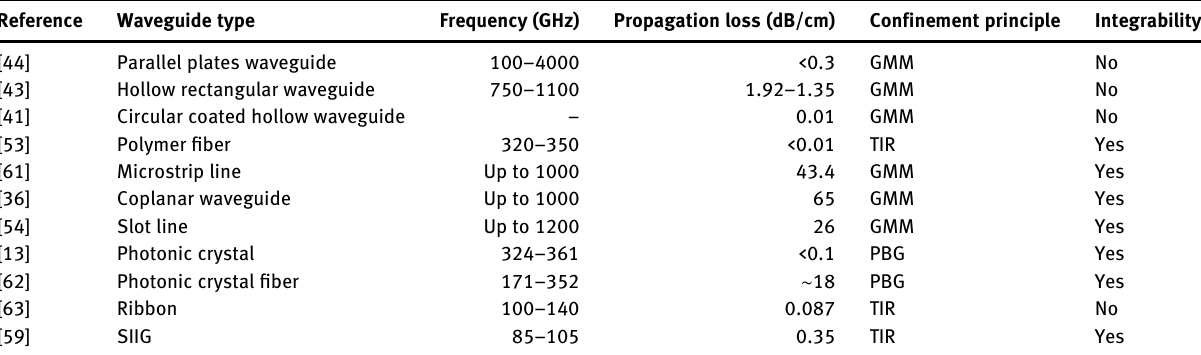
Table  : Performances of various THz waveguides.